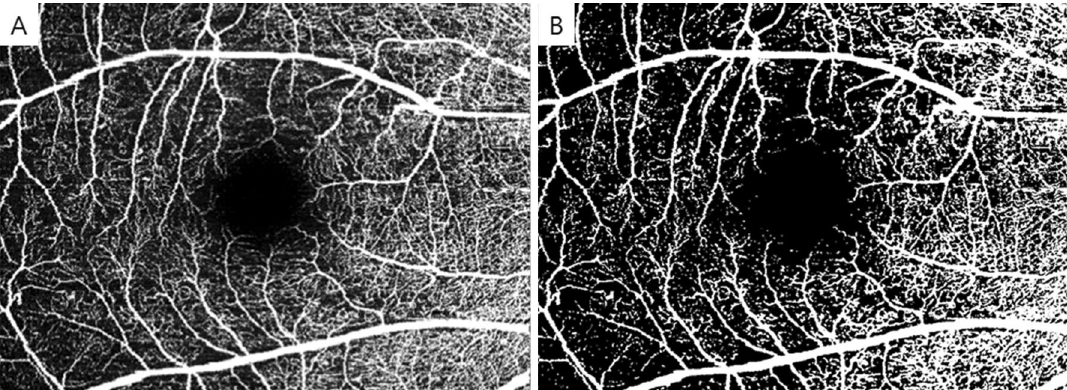
Figure 1. Original optical coherence tomography angiography images of the superficial capillary plexus ( A ) and images after conversion by ImageJ ( B ). Using the binarized image, vessel density was calculated by dividing the area of white pixels by the total number of pixels.